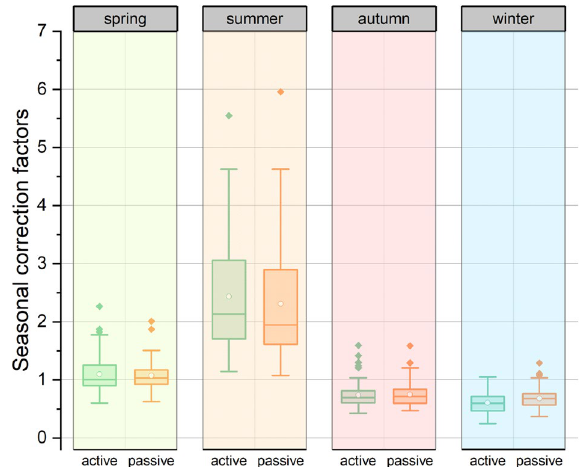
Figure 2. Temporal correction factors for indoor radon concentrations computed at season level for the passive and active methods. The figure was made using OriginPro 2019b software (www. origi nlab. com).